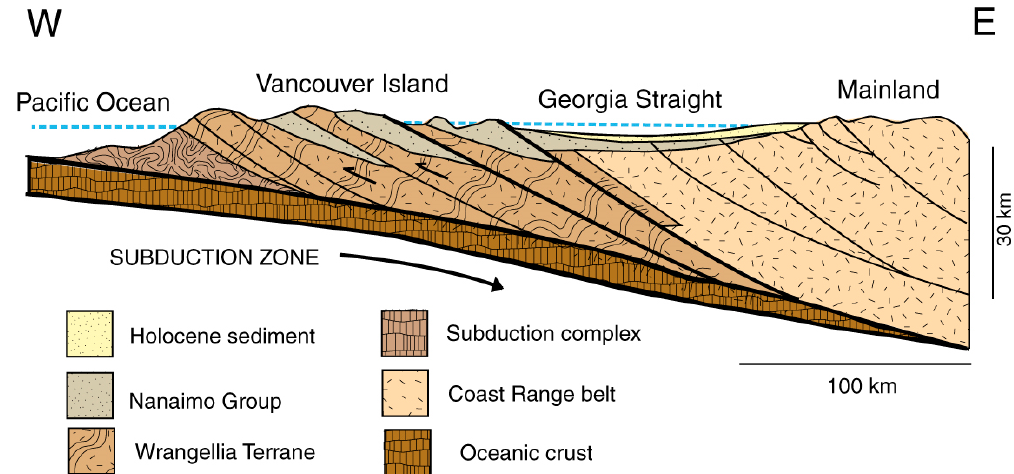
Figure 2. Generalized geological structure of the Upper Cretaceous Nanaimo Group. Adapted from [23].